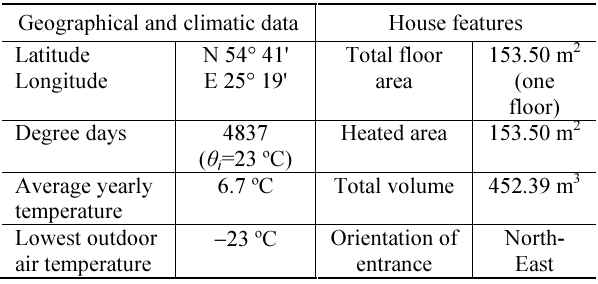
Table 1. Main features and climatic data of the house in Vilnius Geographical and climatic data